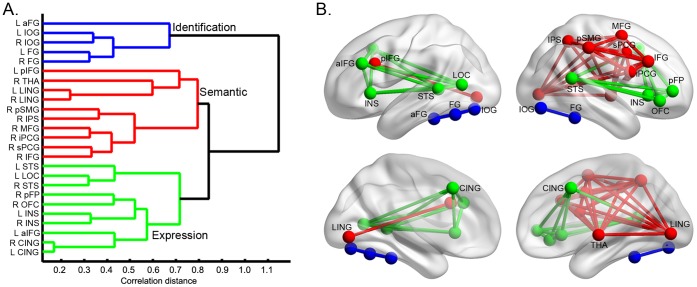
Hierarchically structured face-processing network.(A) Dendrogram from the hierarchy clustering analysis based on the strength of functional connectivity among the face-selective ROIs when the participants performed a face recognition task. The face-processing network consists of three relatively independent sub-networks that correspond to the recognition of individual identity (Identification), retrieval of personal knowledge (Semantic) and analysis of facial expression (Expression). (B) Sub-networks are displayed on the mean MNI152 brain surface with nodes and edges. The sub-network for Identification, Semantic, and Expression is colored with blue, red and green, respectively. Note that for display purposes, edges between the sub-networks are not shown.